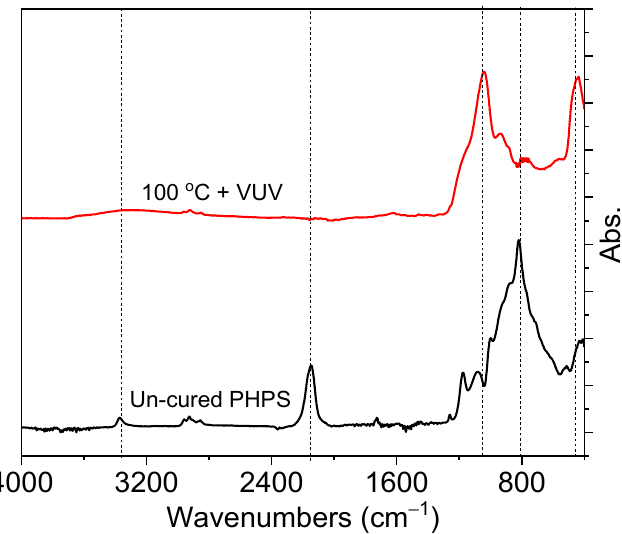
Figure 5. FTIR spectra of PHPS cured with combination of heat and simultaneous irradiation with deep UV at a distance of 5 mm and compared with un-cured PHPS.